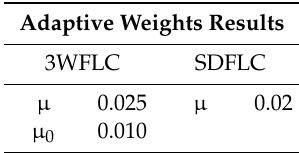
Table 2. Adaptive weights results.